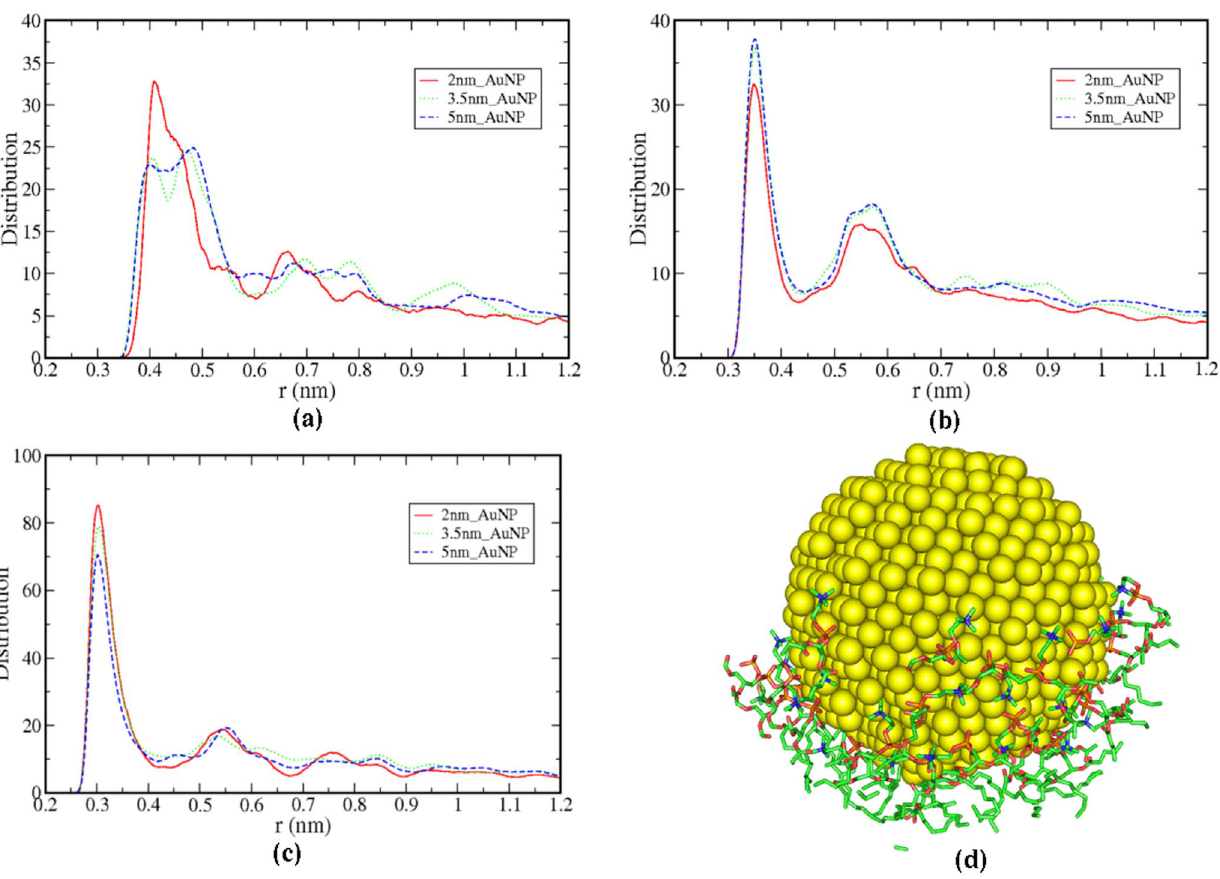
Figure 3. Distance distribution between surface Gold atoms of AuNP and (a) head-group Nitrogen, (b) NMe group’s C atoms and (c) non-ester Oxygens of Phosphate group respectively. d) Snapshot of lipid headgroup interaction with AuNP.